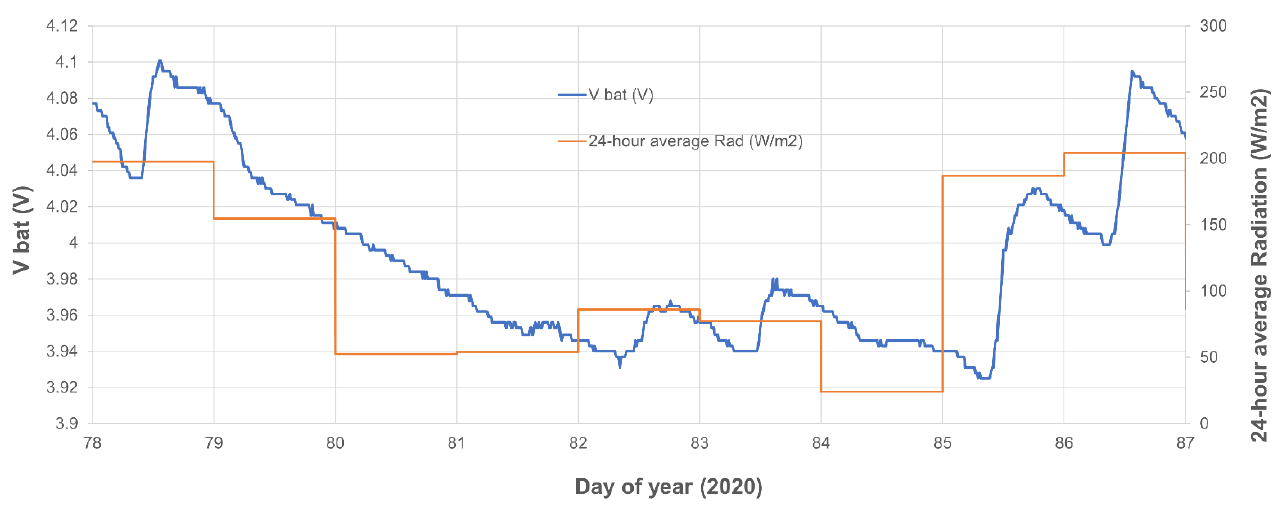
Figure 15. Battery voltage (node 25) vs. daily average radiation (source: http://siam.imida.es/ Agro-Meteorological Weather Station CA12-La Palma, accessed on 6 April 2020). Cloudy days.